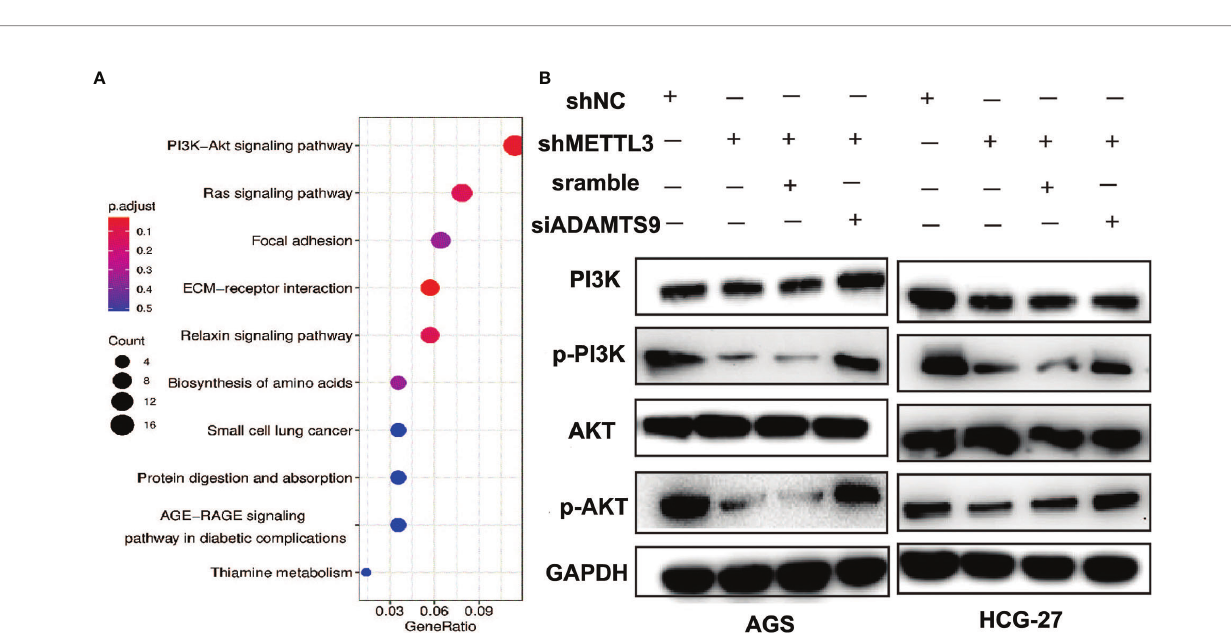
FIGURE 7 | METTL3 promotes GC progression through ADAMTS9-mediated PI3K/AKT signaling. (A) Top 10 enrichment KEGG pathways of dysregulated genes in METTL3-knockdown GC cells. (B) The activation of PI3K/AKT signal pathway was evaluated using Western blot in GC cells with indicated gene knockdown. GAPDH was used as a loading